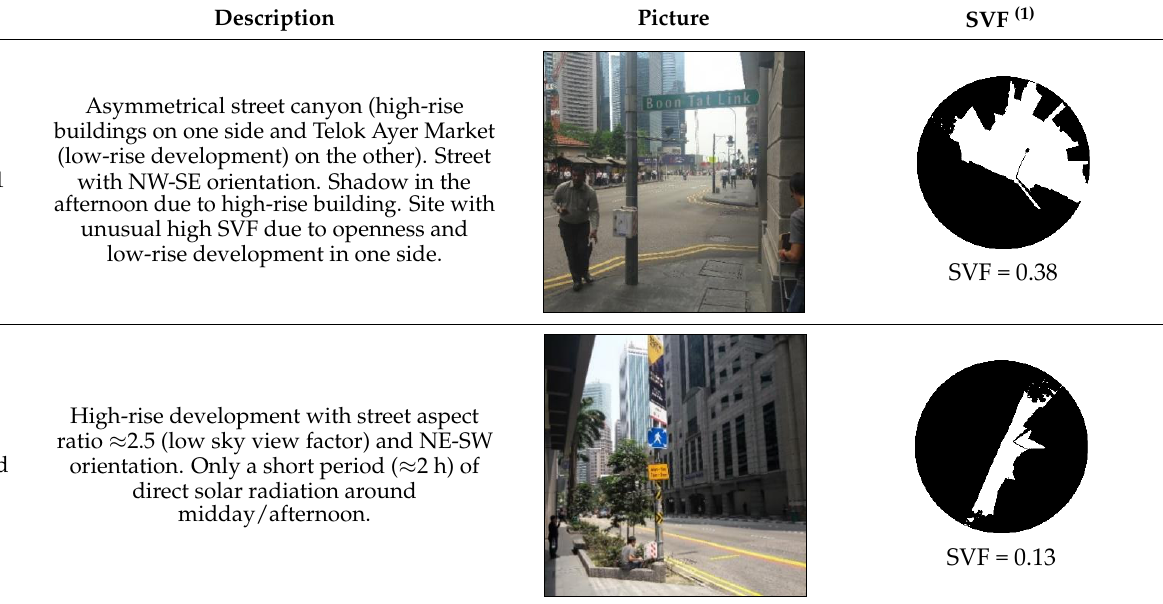
Table 2. Description of the sites in the CBD area were measurements were carried out.